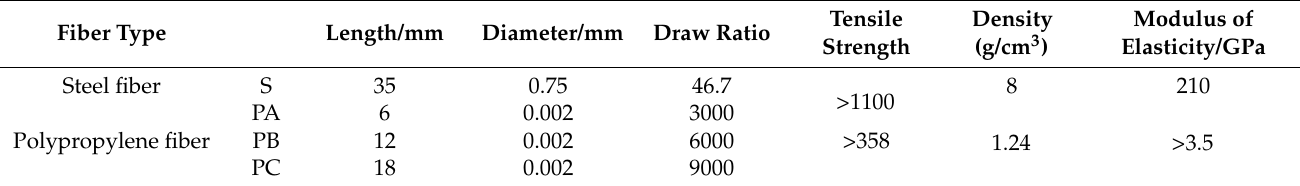
Table 5. Performance index of each